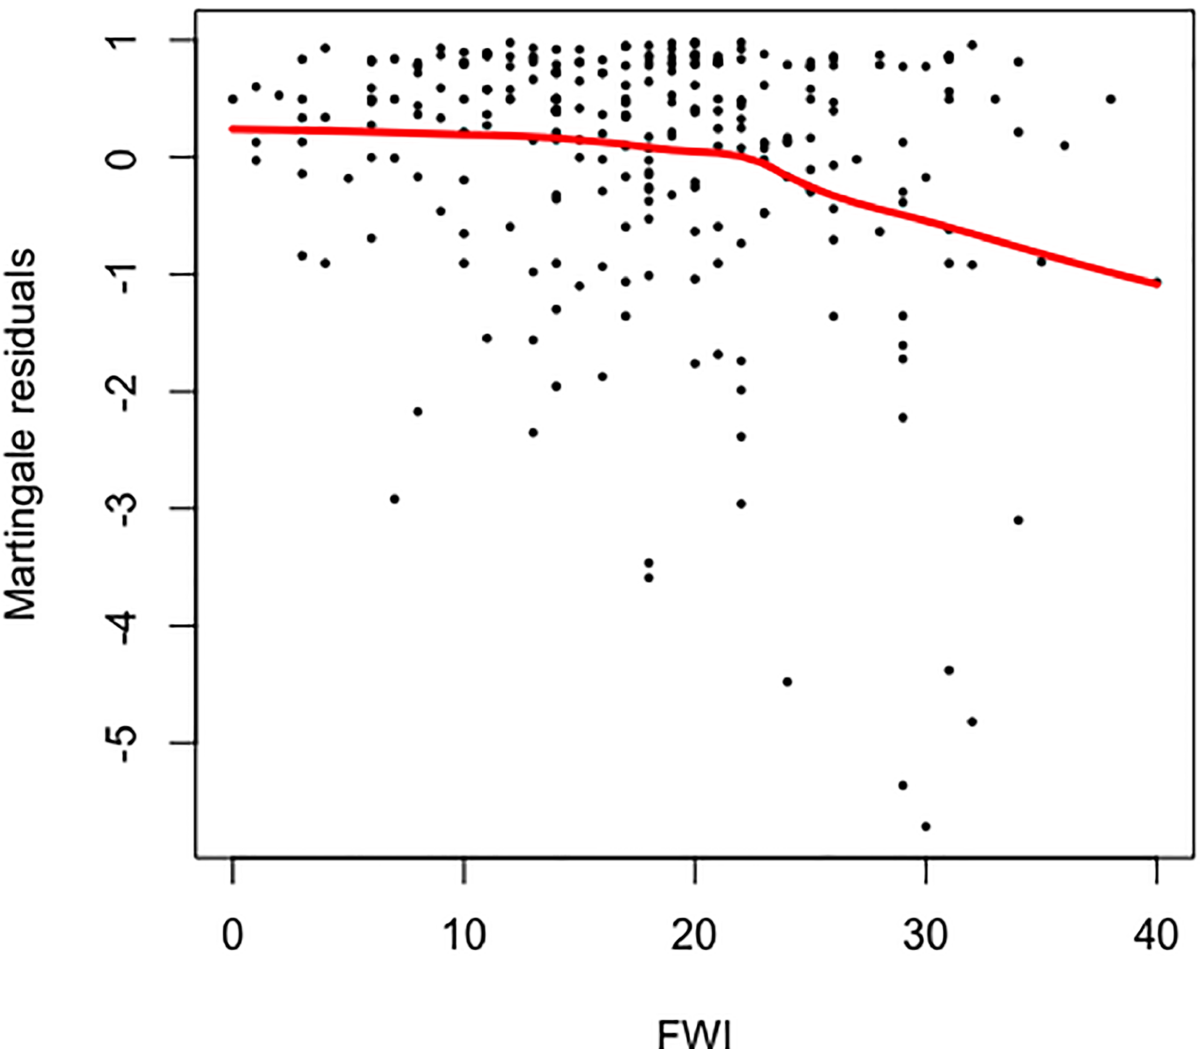
Fig 4. Martingale residuals of Fire Weather Index variable. Locally Weighted Scatterplot Smoothing (LOWESS) (red line) of the martingale residuals shows that they are approximately uncorrelated with mean 0, suggesting that FWI linear functional form is indicated.